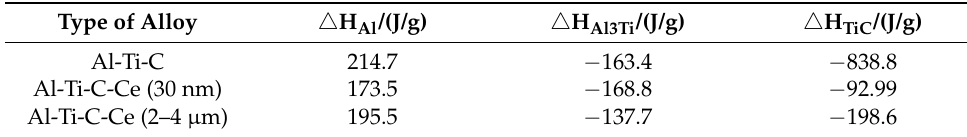
Table 2. The corresponding heat change of the reaction.